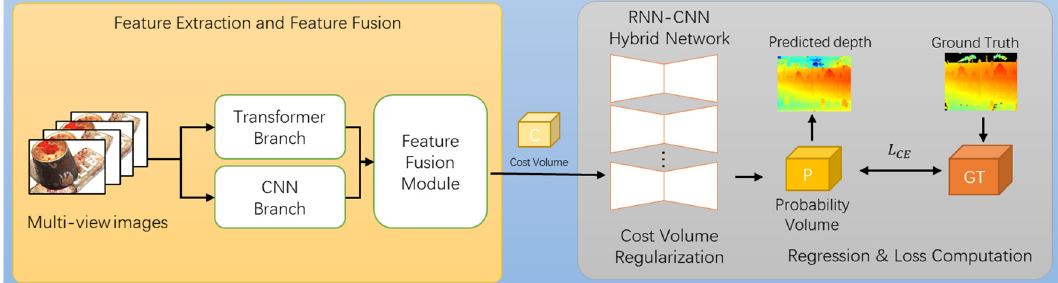
Figure 1. Overview of proposed